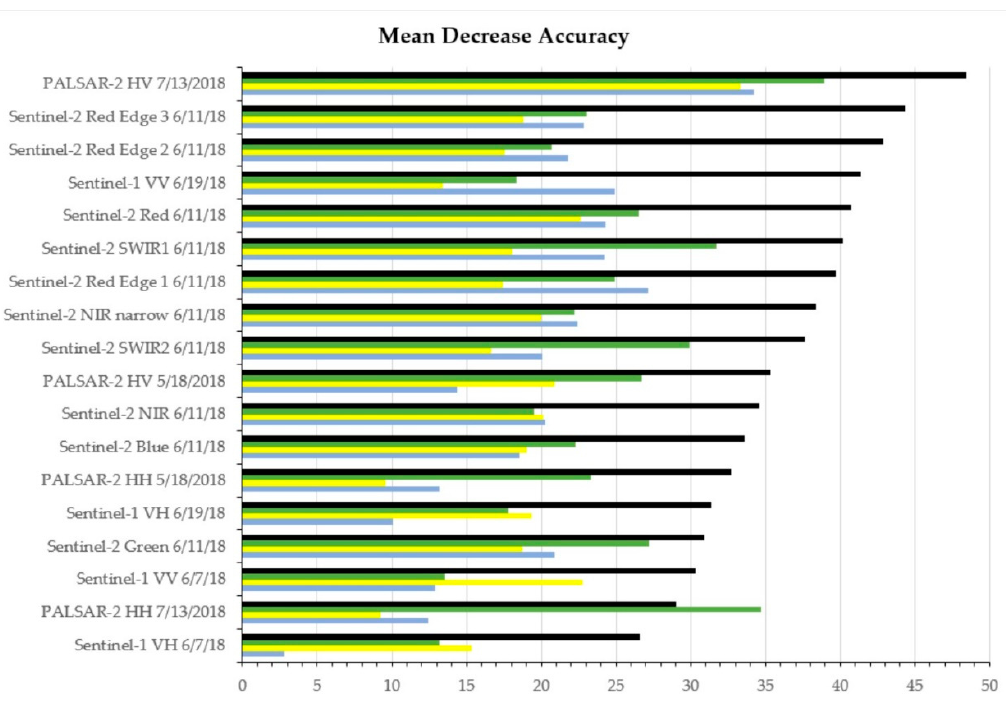
Figure 4. Mean Decrease Accuracy for all classes (black), short grass (green), medium grass (yellow), and tall grass (blue).